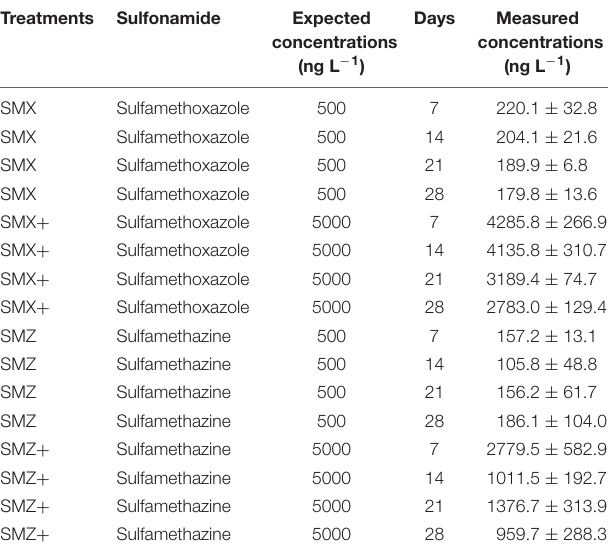
TABLE 1 | Sulfonamide concentrations measured in the water of the channels. Treatments